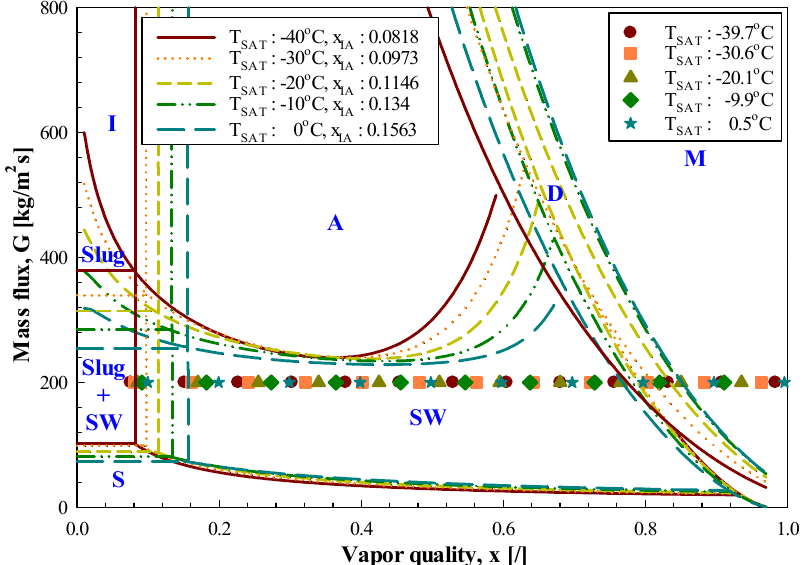
Figure 5. Flow pattern map for R744 according to various saturation temperatures at constant mass flux (200 kg/(m 2 ·s)) and heat flux (20 kW/m 2 ).